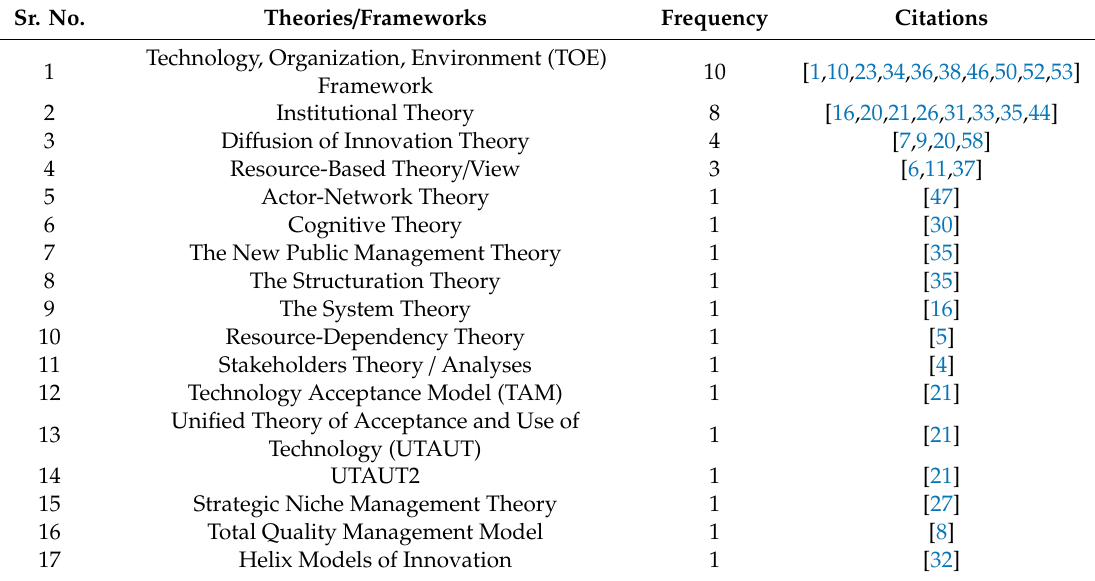
Table 7. List of Theories /